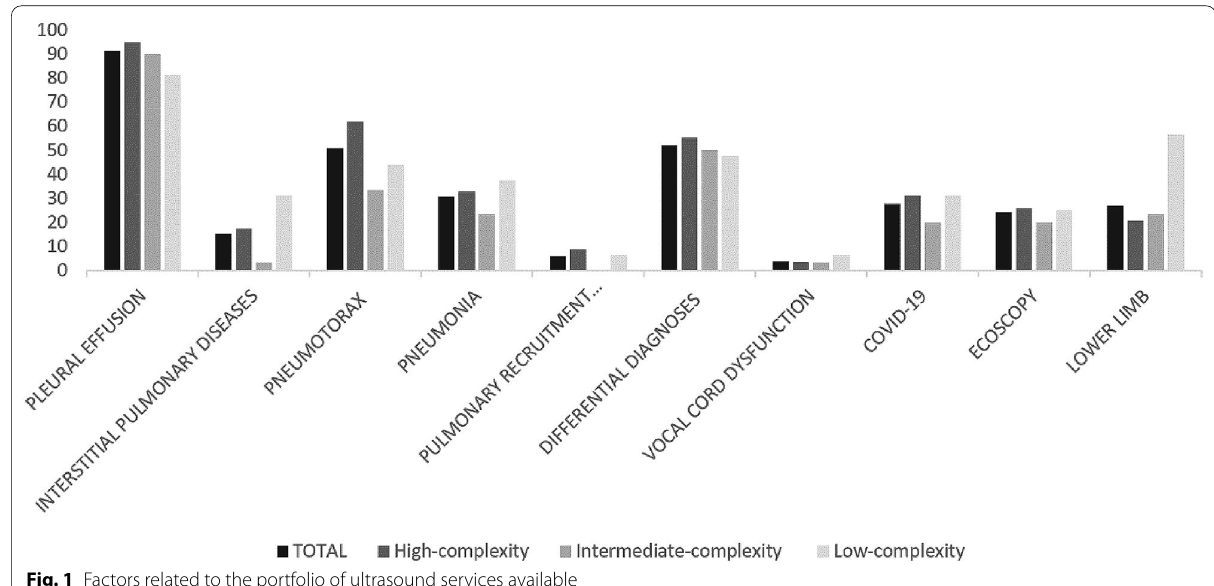
Fig. 1 Factors related to the portfolio of ultrasound services